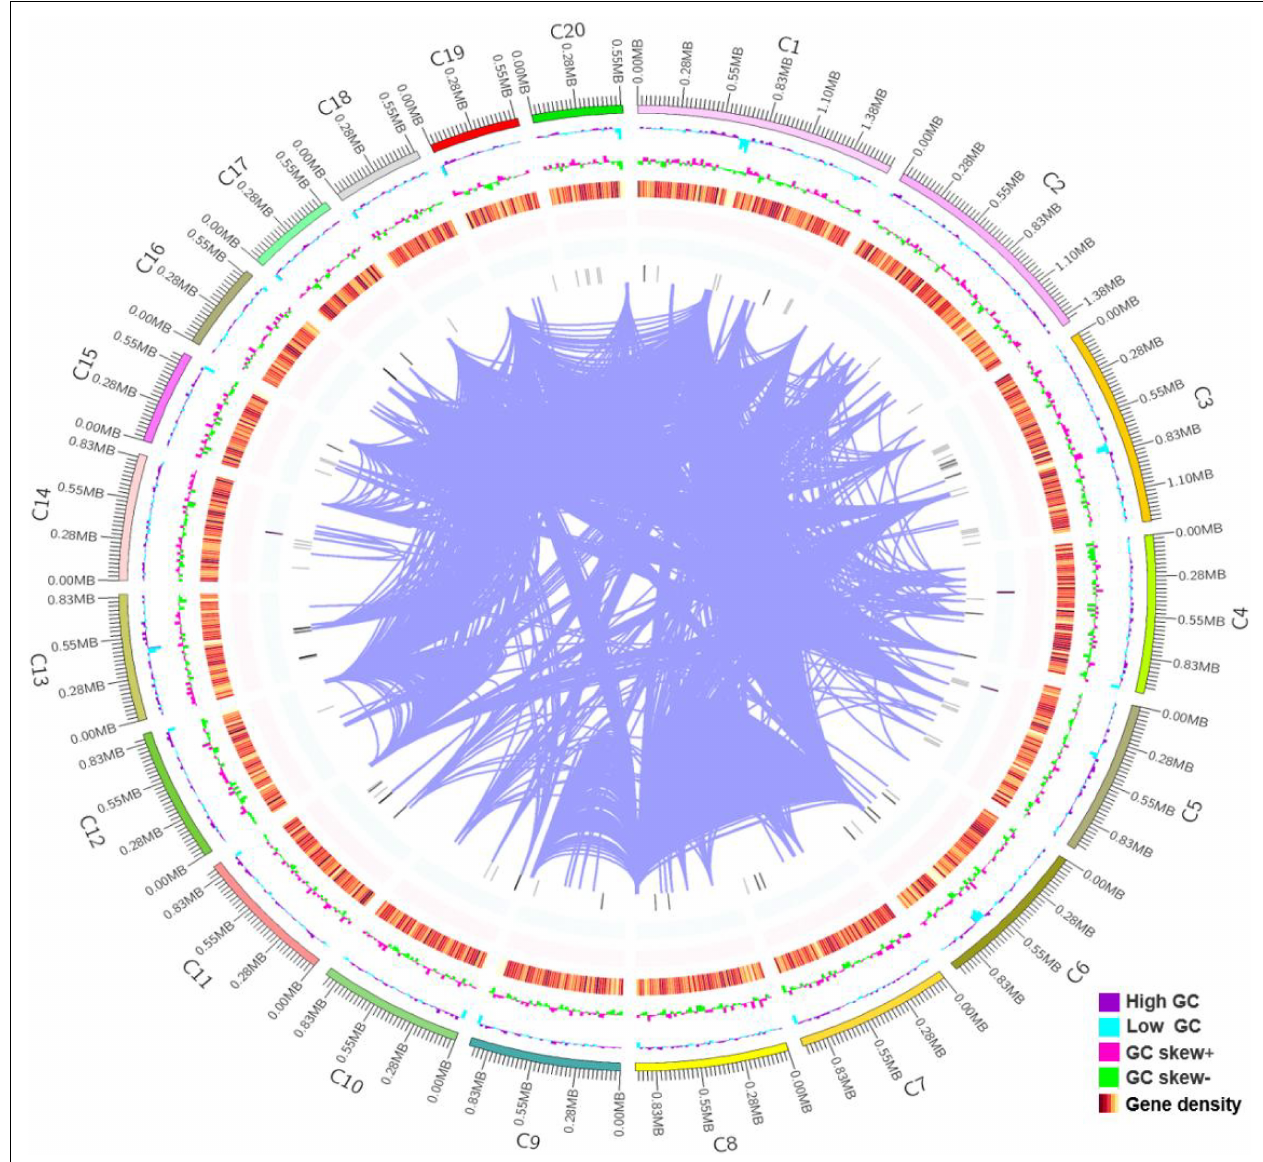
FIGURE 1 | Genomic features of Rhodotorula glutinis X-20. The 21.6 Mb genome of R. glutinis X-20 contains 20 scaffolds (the longest length scaffold of 1,634,659 bp, a N50 length of 913,949 bp, sum of Contig Lengths of 21,850,050 bp, GC content of 68.21%). The R. glutinis X-20 genome encodes 6,892 predicted proteins and 157 transfer RNAs (tRNAs), which are validated by RNA-seq. From the outer circle to the inner, it represents the length of scaffolds, GC content is higher than the average (purple), GC content is lower than the average (blue), GC skew curve (Pink: positive GC skew; Green: negative GC skew) and the gene density of coding genes, rRNA, snRNA, tRNA (gradient color), the darker the color, the greater the gene density in the window and chromosome duplication,